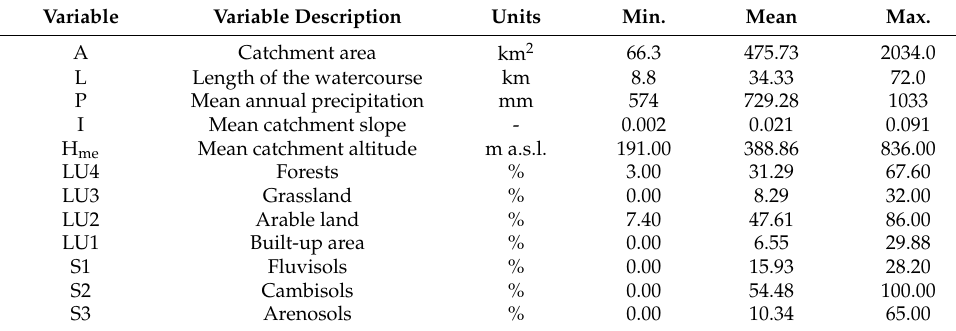
Figure 1. The location of the Upper Vistula river basin and analyzed catchments (points show the location of the catchment areas selected for the analysis). Table 1. Statistical summary of catchments’ characteristics.